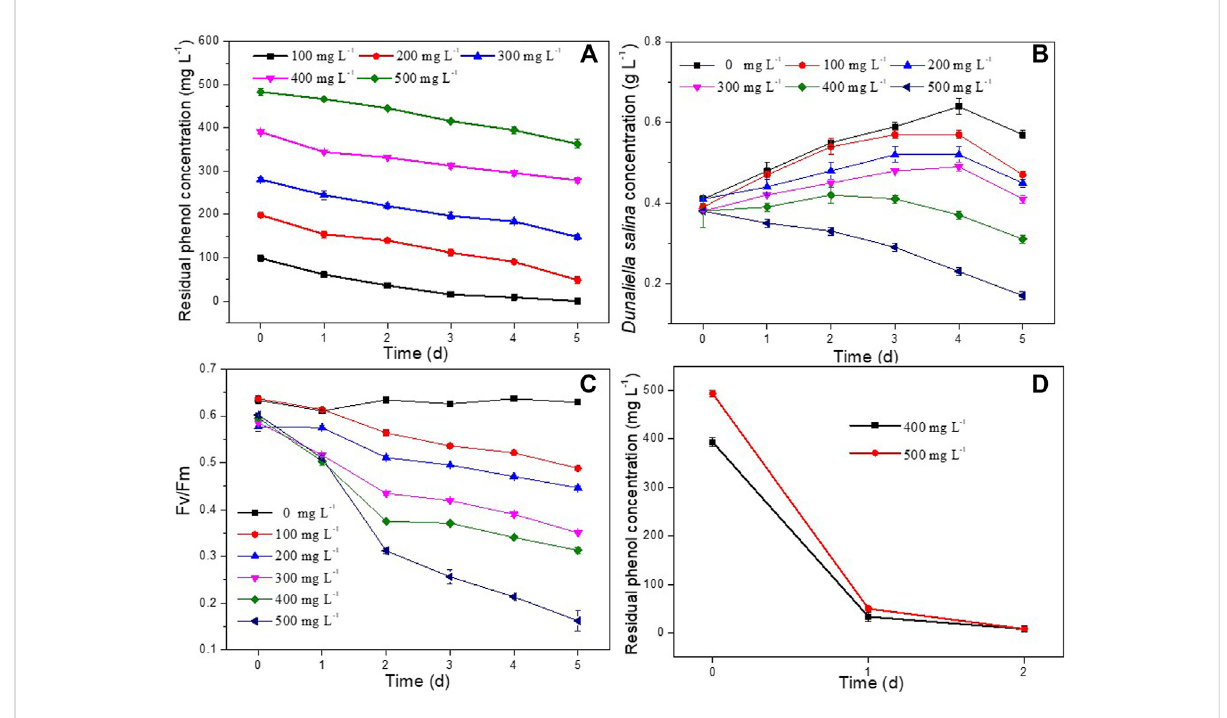
FIGURE 1 Effect of phenol concentrations on residual phenol concentrations, biomass concentrations and Fv/Fm values of D. salina (A – C) and H. mongoliensis (D)